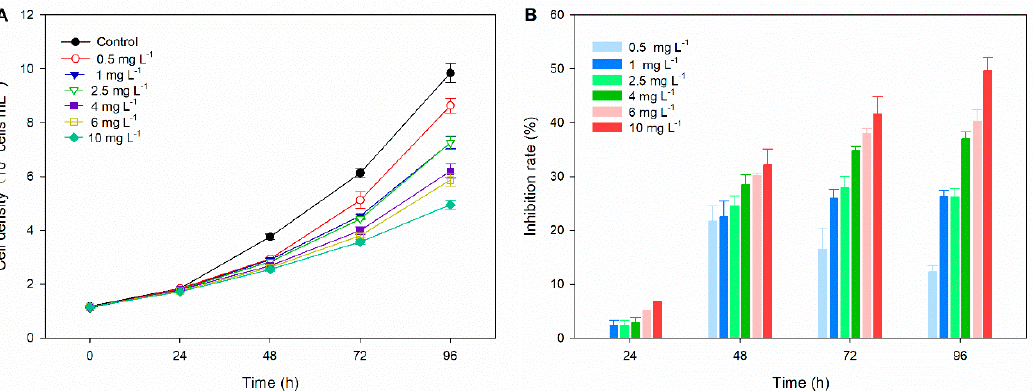
Figure 1. Effects of TC on the growth ( A ) of C. pyrenoidosa and its inhibition rates ( B ) during 96 h exposure in different treatments.